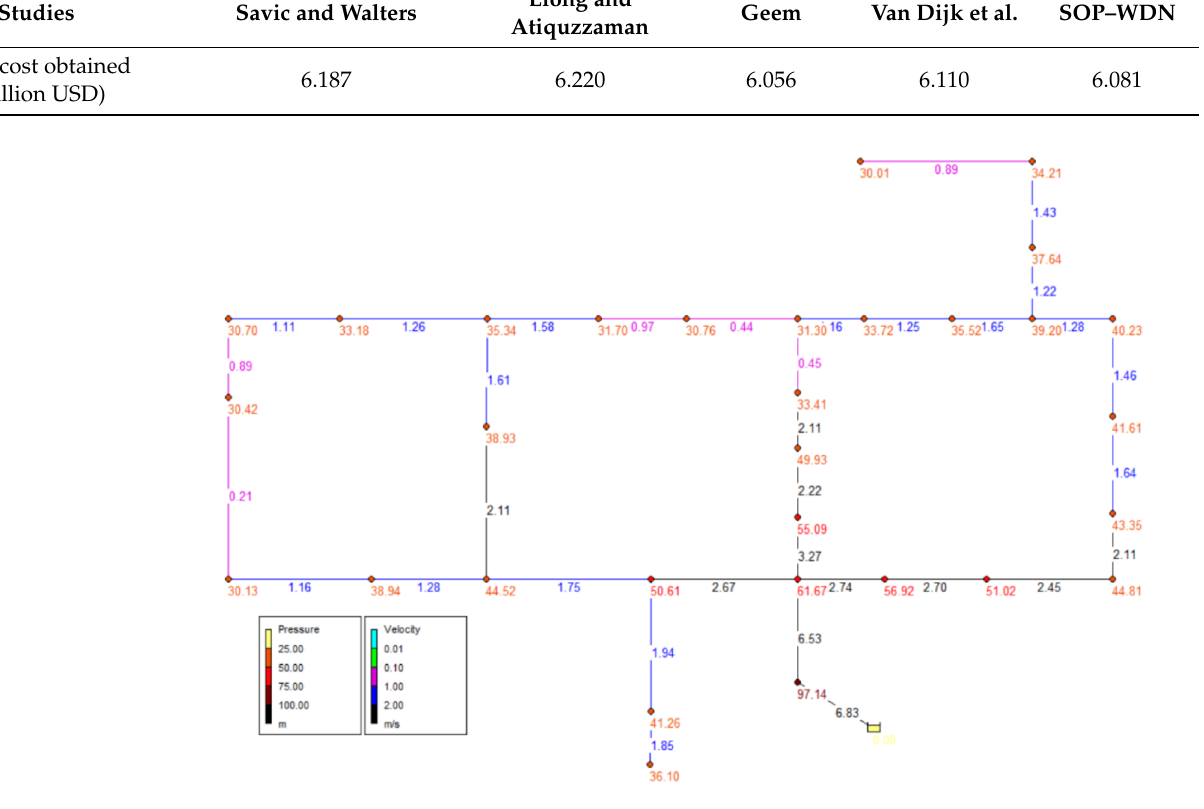
Figure 10. The Hanoi network solution obtained (pressure and